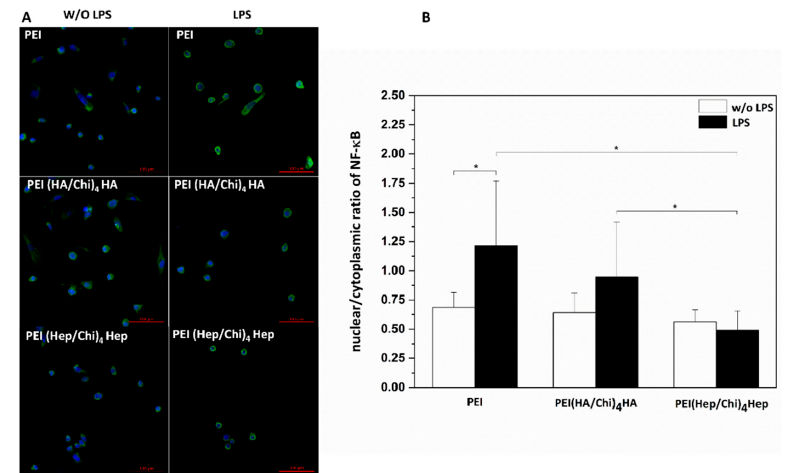
Figure 8. ( A ) TO-PRO-3 (blue colour) staining of nuclei and monoclonal antibody detection (green colour) of NF- κ B p65 subunit shown for non-stimulated (left row) and stimulated (1 μ g·mL − 1 LPS) macrophages (right row). The cells were cultured for 48 h on poly (ethylene imine) (PEI) and terminal layers of PEMs composed of either hyaluronic acid (HA) or heparin (Hep) as polyanions and chitosan (Chi) as polycation abbreviated as (PEI(HA / Chi) 4 HA, PEI(Hep / Chi) 4 Hep), respectively. Scale bar: 100 µ m. ( B ) Quantification of nuclear / cytoplasmic ratio in absence (white bars) and presence (black bars) of LPS in cells cultured on PEI and PEMs. Data represent means ± SD, n = 10, * p ≤